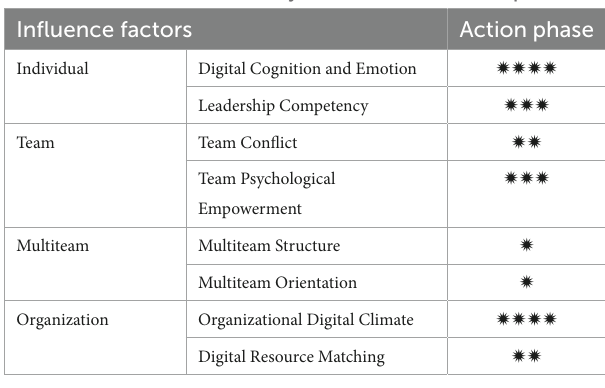
TABLE 5 Difference in the centrality of MTDC in the transition phase.